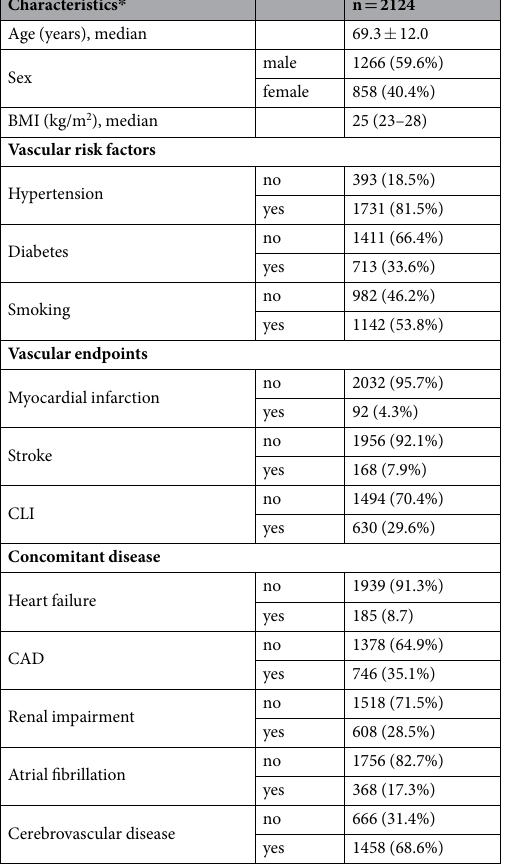
Table 1. Patient’s characteristics. * Results are provided as n (%) or median ( ± interquartile range) Abbreviations: BMI, Body Mass Index; CLI, critical limb ischemia; CAD, coronary artery disease.